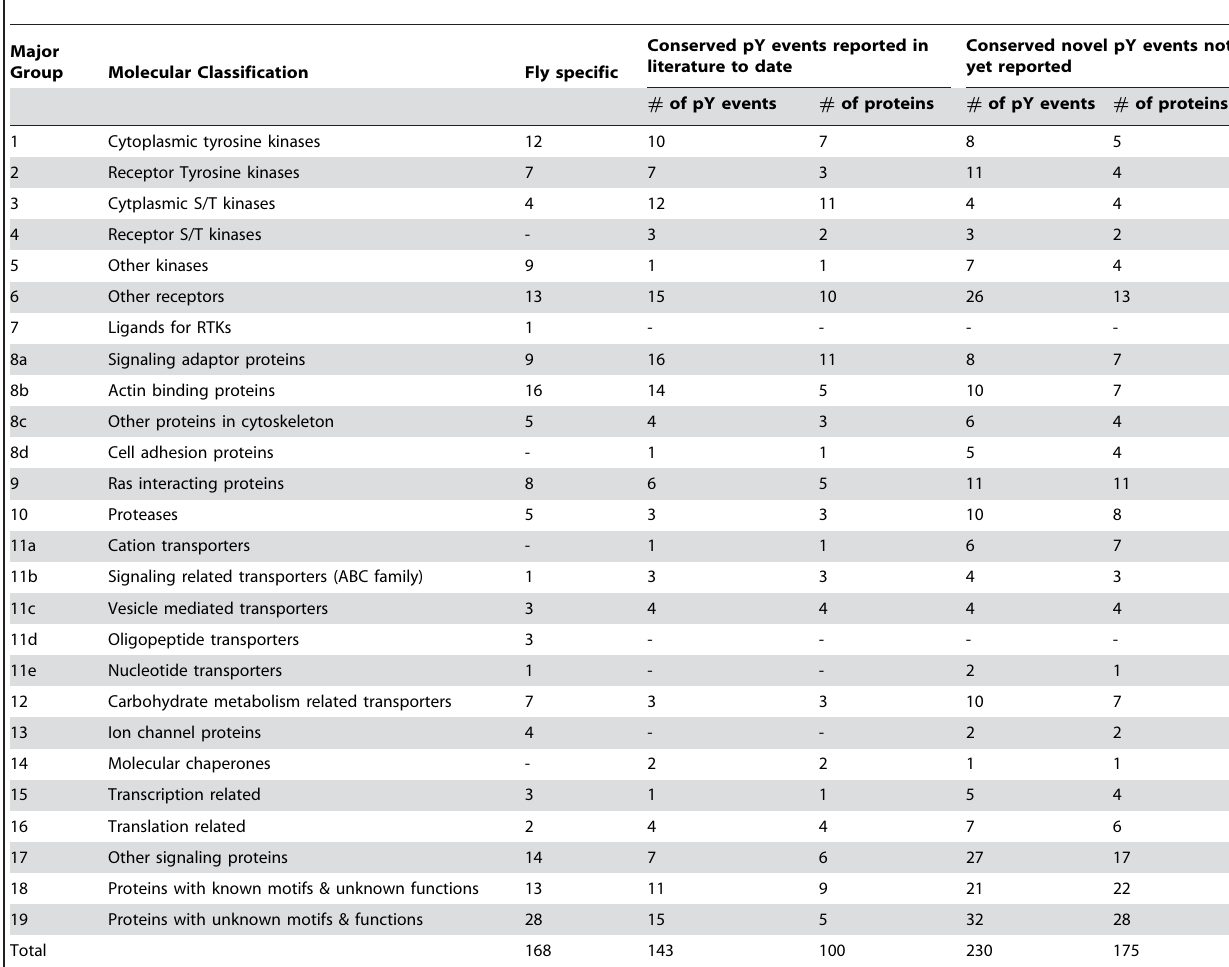
Table 1. Summary of proportion of tyrosine phosphorylation sites in Drosophila RTK proteome based on molecular functional